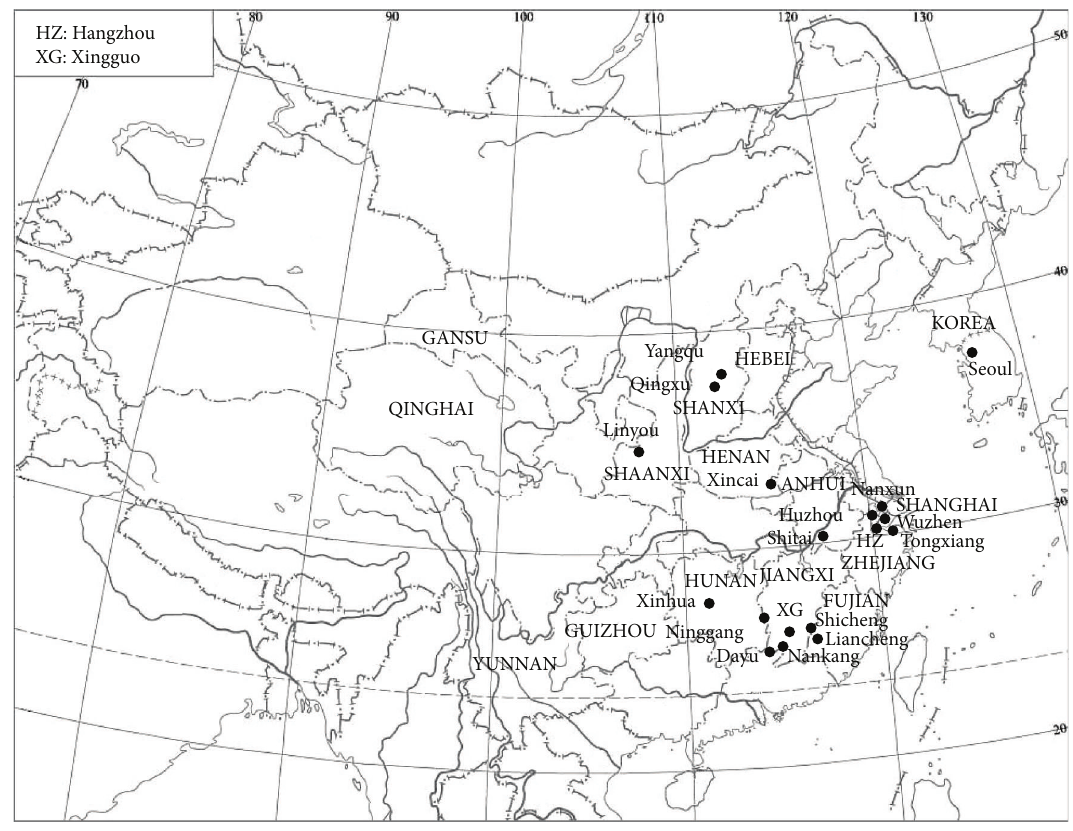
Figure 2: Epidemics in 1601 AD in China and Korea. Capitalized place names are Korea and provinces of China.